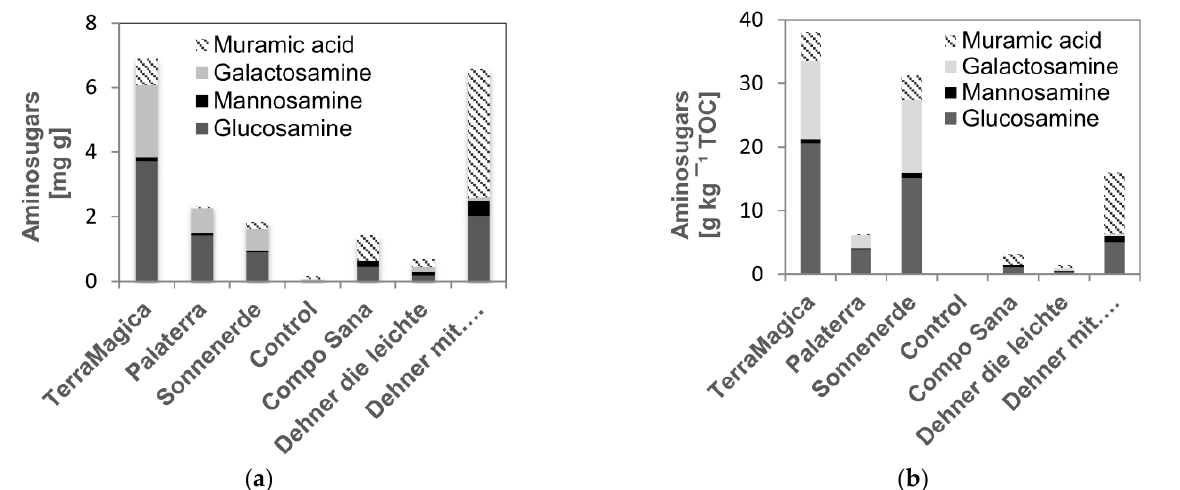
Figure 7. Amino sugars content and distribution in biochar- and peat-based growing media ( a ) referred to soil ( b ) referred to soil organic C.